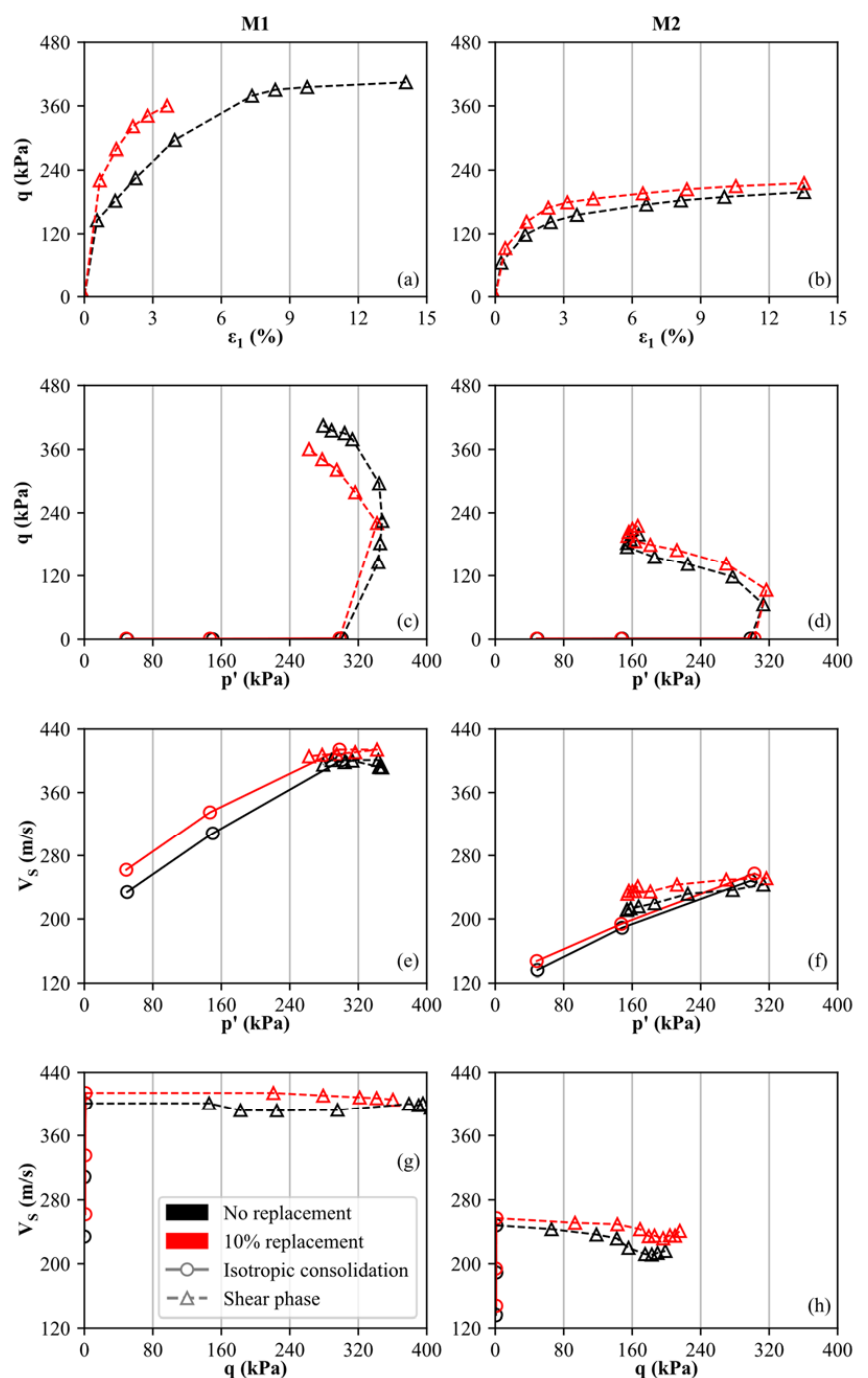
Figure 6. Results of triaxial and bender element tests, executed on uncemented and artificially cemented soil specimens: ( M1: ( a , c , e , g ) column, M2 : ( b , d , f , h ) column).